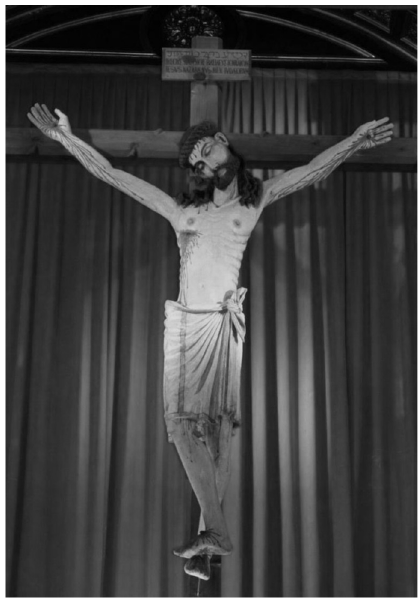
Figure 1. Crucifix of the Saviour, 13th–14th century, parish of the Saviour, Valencia. © Parish of the Saviour of